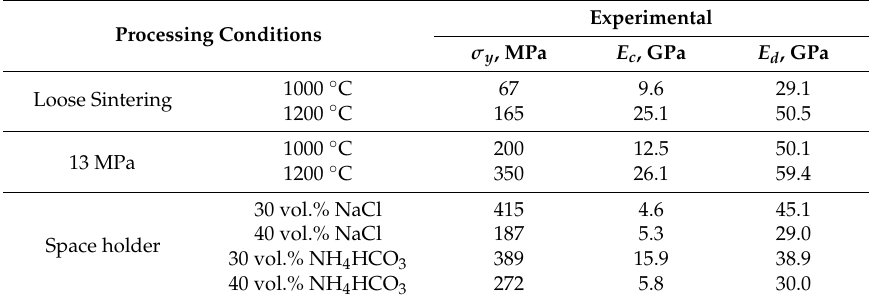
Table 3. Effect of different techniques and processing conditions on mechanical properties of the samples obtained by compression test and ultrasound testing.